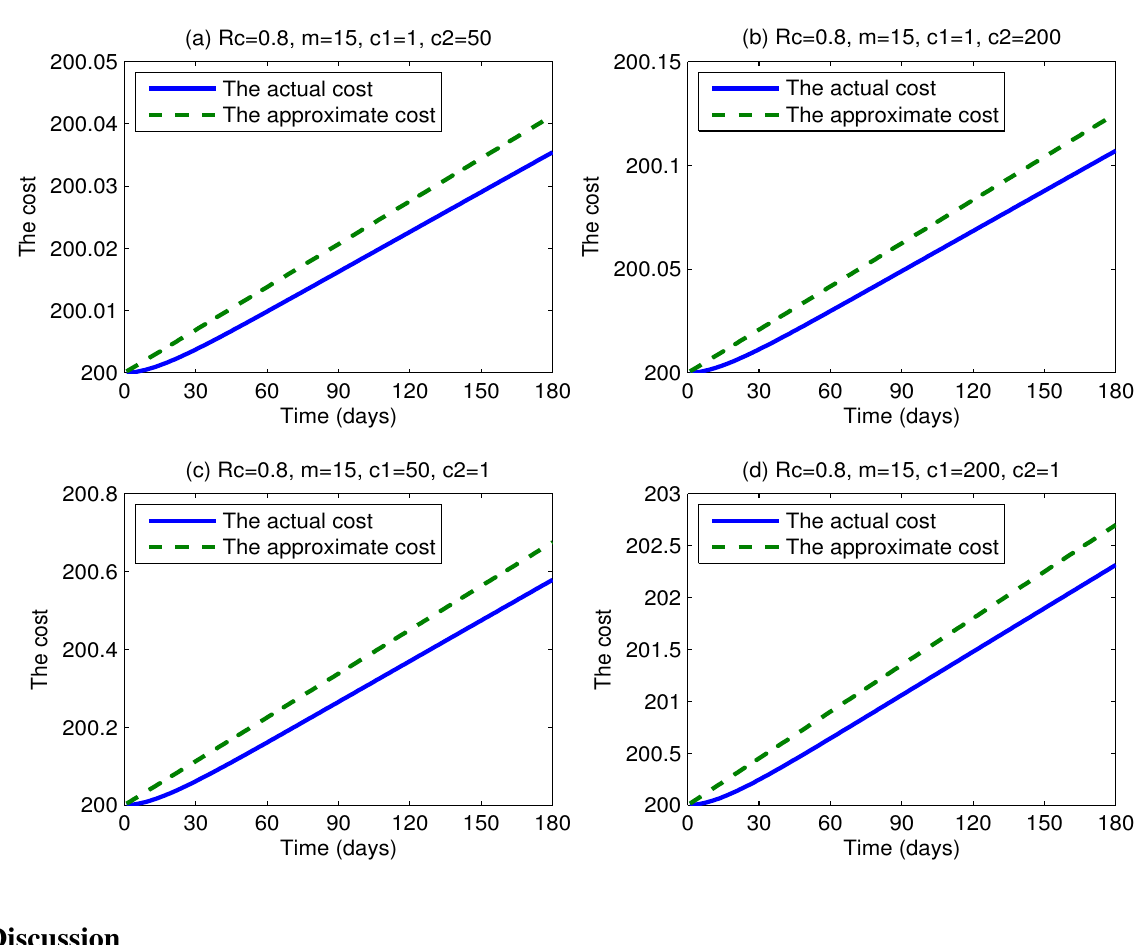
Figure 13. Plots of the actual intervention cost and the approximate intervention cost versus time t for various values of c c = 100 and c 3